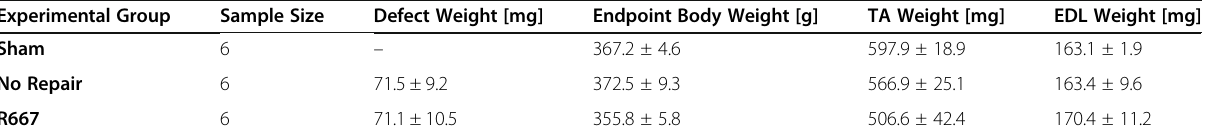
Table 1 Gross anatomy and muscle weights Experimental Group Sample Size